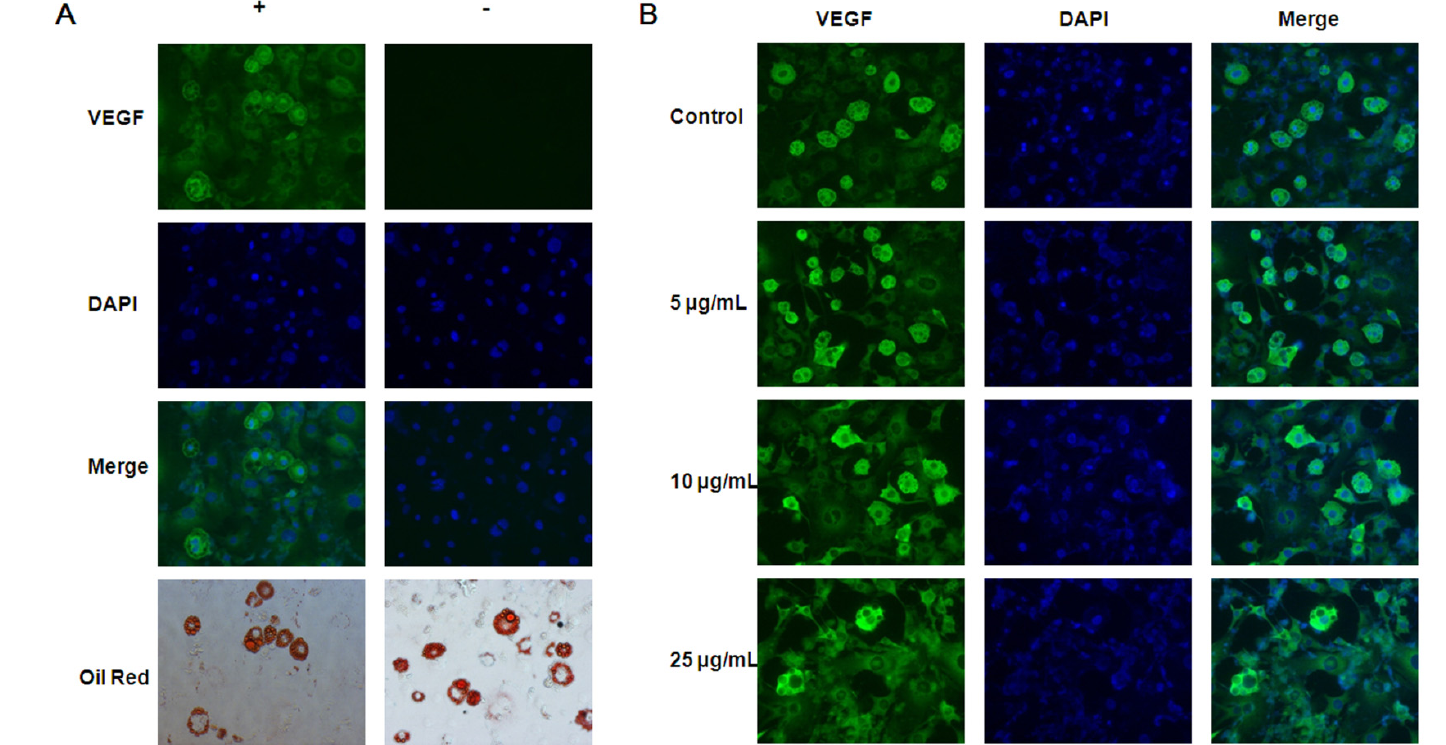
Figure 5. The ( − ) ‐ Epigallocatechin ‐ 3 ‐ gallate (EGCG) regulation of vascular endothelial growth factor (VEGF). ( A ) 3T3 ‐ L1 adipocytes that were fixed, permeabilized, stained with or without VEGF (green). Cell nuclei were stained with DAPI (blue). Lipid droplets were stained with Oil Red O. The results were observed by fluorescence microscope; ( B ) Cells treated with EGCG 0–25 μ g/mL during differentiation, fixed, permeabilized and double stained with VEGF and anti ‐ mouse 448 secondary antibody (green). Cell nuclei were stained with DAPI (blue) (magnification: ×200). Results were representative of three independent experiments, n = 3.